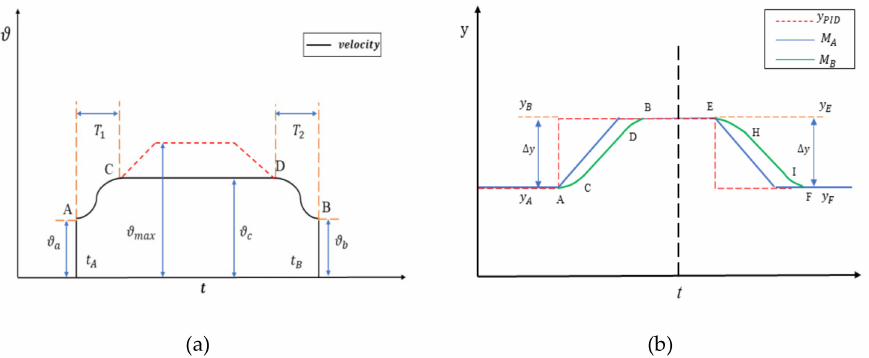
Figure 5. S-curve acceleration and deceleration control algorithm. ( a ) The action speed variation curve of the guide vane; ( b ) The position change of the guide vane